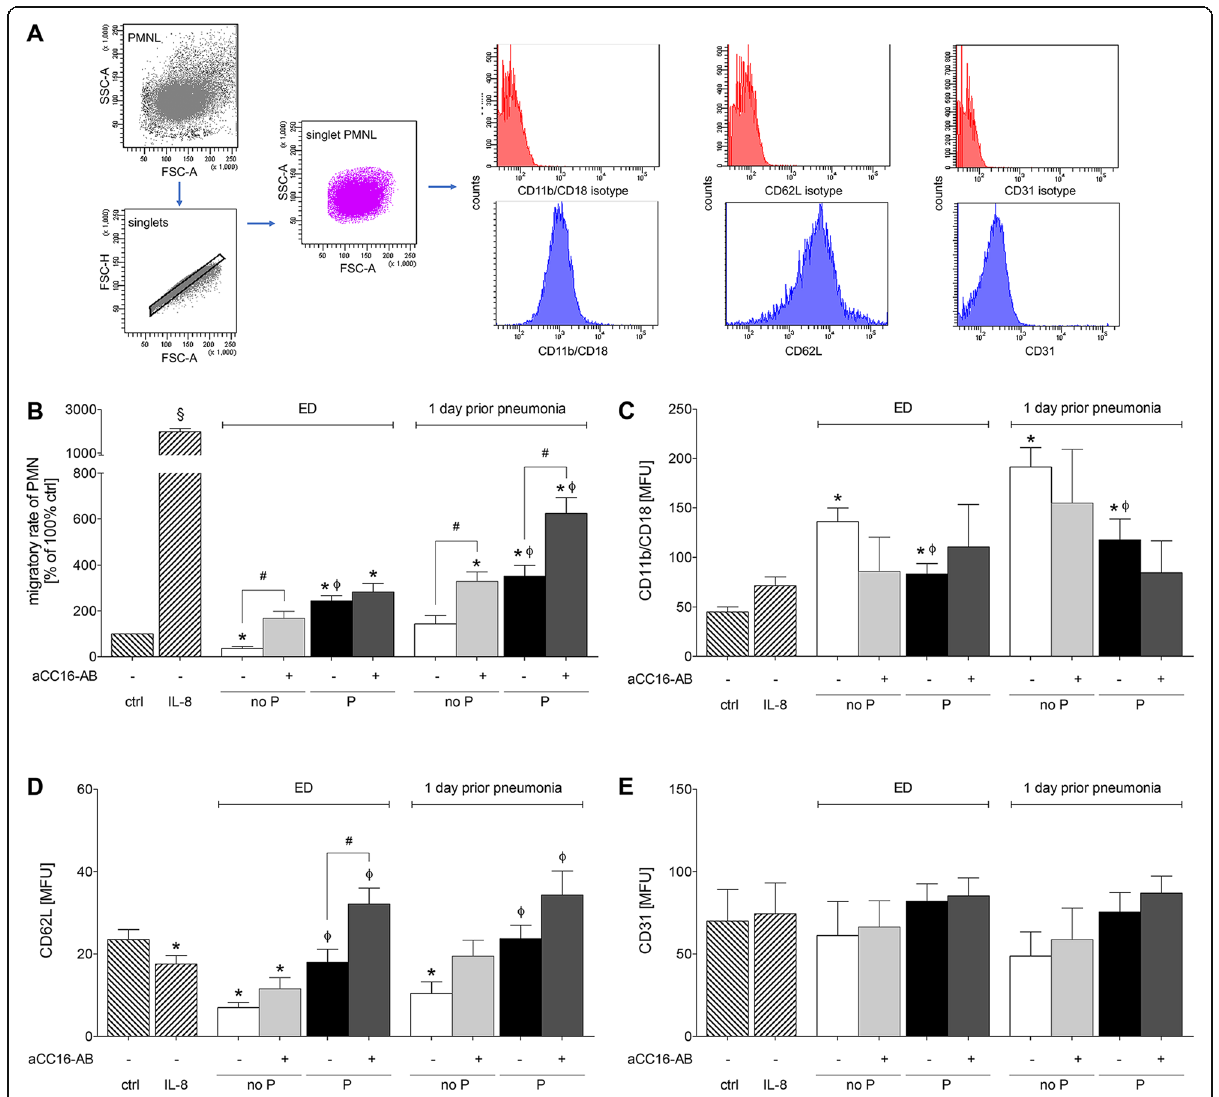
Fig. 2 Increased PMNL migration upon CC16 neutralization is associated with concurrently enhanced CD62L. a Gating strategy of isolated PMNL and representative stainings for isotype or anti CD11b/CD18, CD62L and CD31 antibodies for the MFU evaluation is shown. Migratory rate of PMNL and CD11b/CD18, CD31, CD62L expression on PMNL after their incubation with serum samples from severely injured trauma patients. Patients were grouped to no P group without pneumonia or P group with pneumonia. Samples were obtained at admission to emergency department (ED) and one (Sadeghi-Bazargani et al. 2018) day prior to pneumonia. Samples from the equal post-injury days in the corresponding no P group were used. b Migratory rates of PMNL isolated from healthy volunteers towards IL-8 or sera from trauma patients with or without CC16 neutralization (aCC16-AB) is shown. c CD11b/CD18 expression, ( d ) CD62L expression and ( e ) CD31 expression on neutrophils is shown. Data are represented as mean ± SEM. p < 0.05: §: vs. all; *: vs. ctrl; Ф : P vs. corresponding no P group; #: CC16 vs.